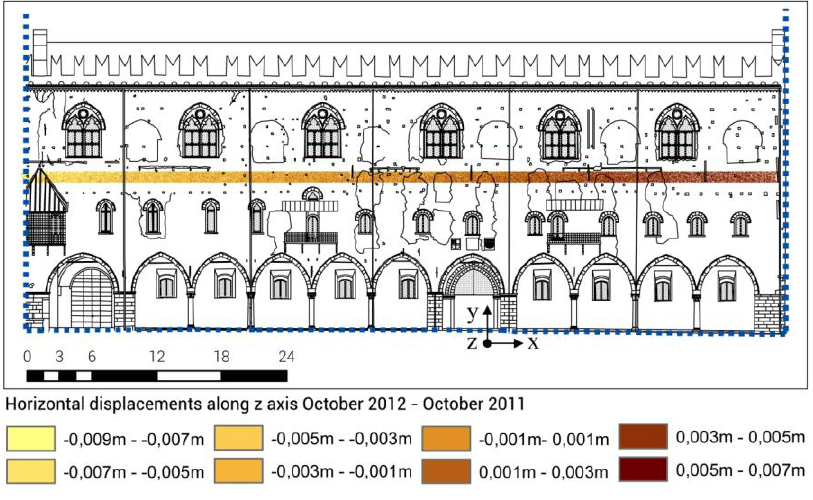
Figure 17. TLS data analysis in ArcGIS software: horizontal displacements calculation by means of the area-based